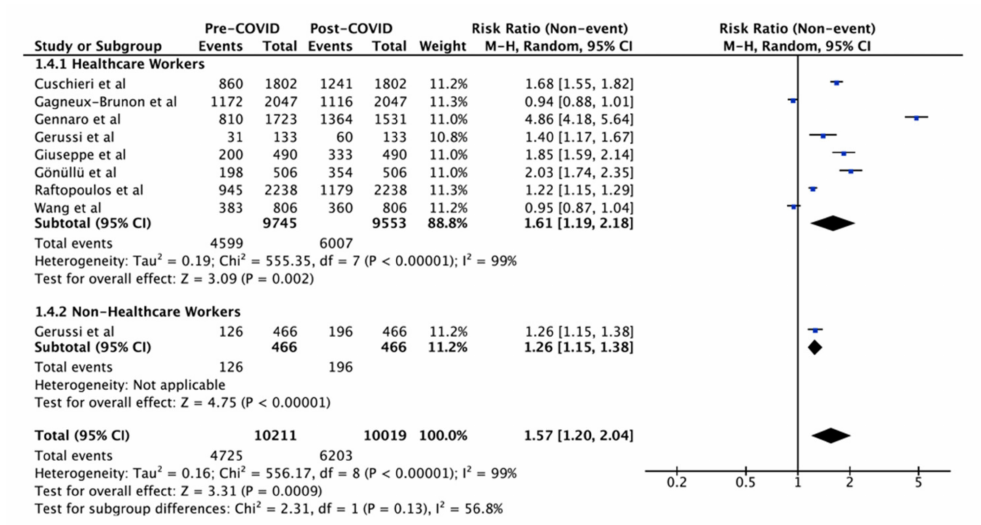
Figure 4. Influenza vaccination uptake pre-COVID-19 vs intention post-COVID-19 by occupation. The squares and rhombus represent the individual and pooled point effect estimates with 95% confidence intervals respectively.